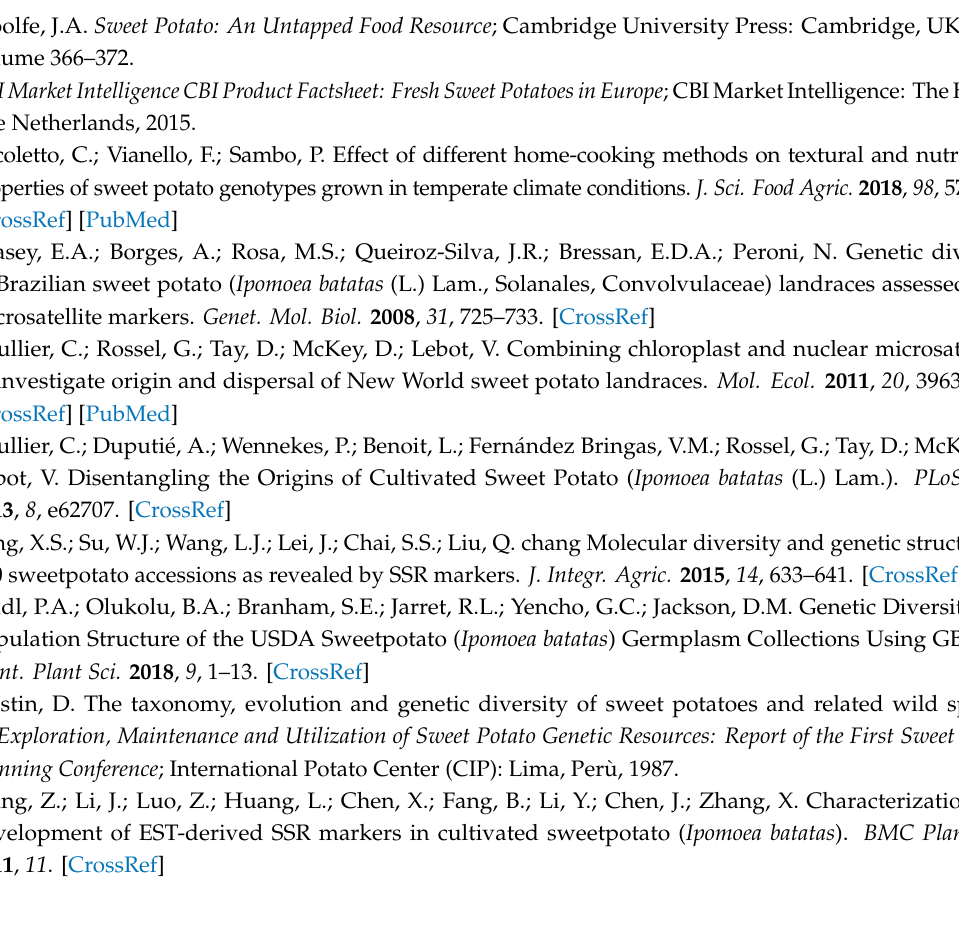
Figure S1: Definition of the number of ancestral sweet potato genotypes. Mean ∆ K is calculated as L”(K) / (SD(L(K))) following Evanno et al. (Evanno et al. 2005), where mean LnP(D) ± SD over 10 runs is a function of K, being L’(K) = ∆ LnP(D), Table S1: SSR data recorded for the di ff erent sweet potato genotypes, Table S2: Genetic similarity matrix for the sweet potato